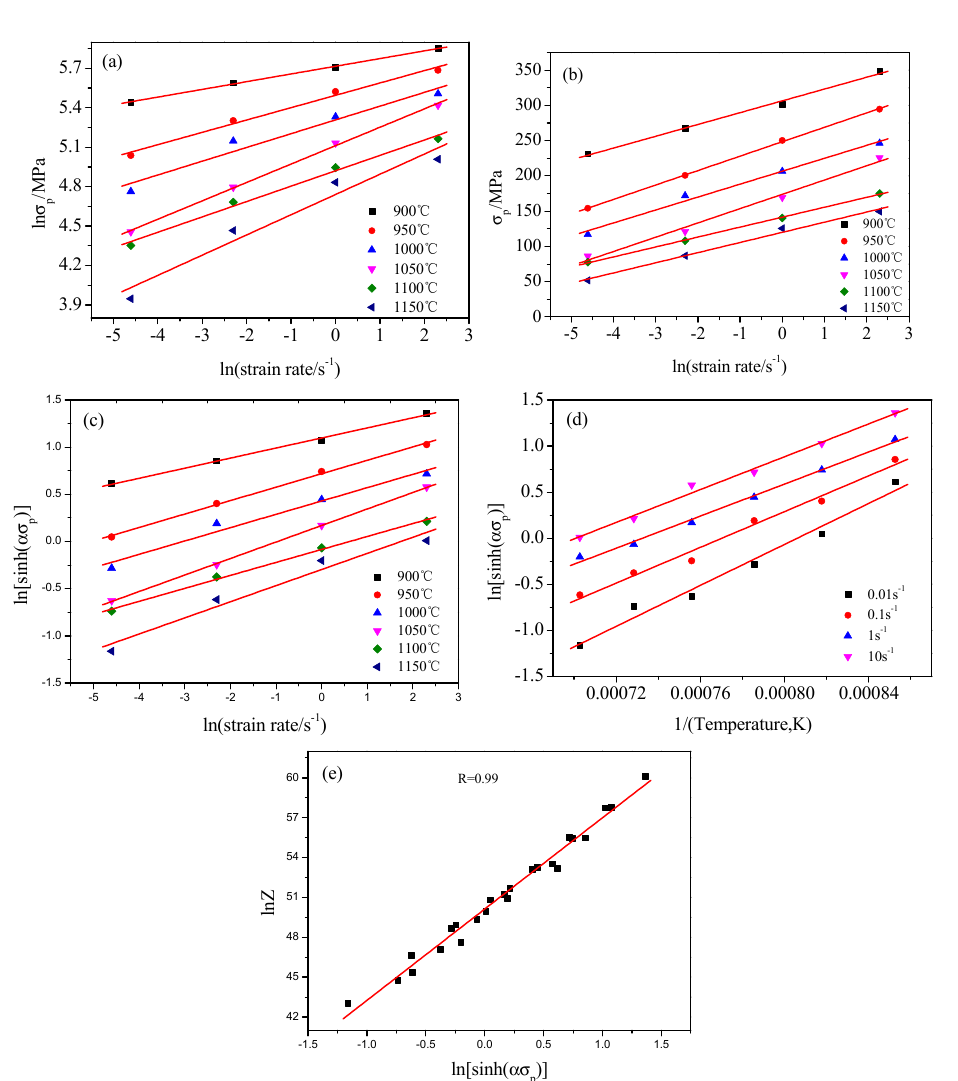
. . . ε ( b ) σ p and ln ε ( c ) ln [ sin h ( ασ p )] and ln ε ( d )